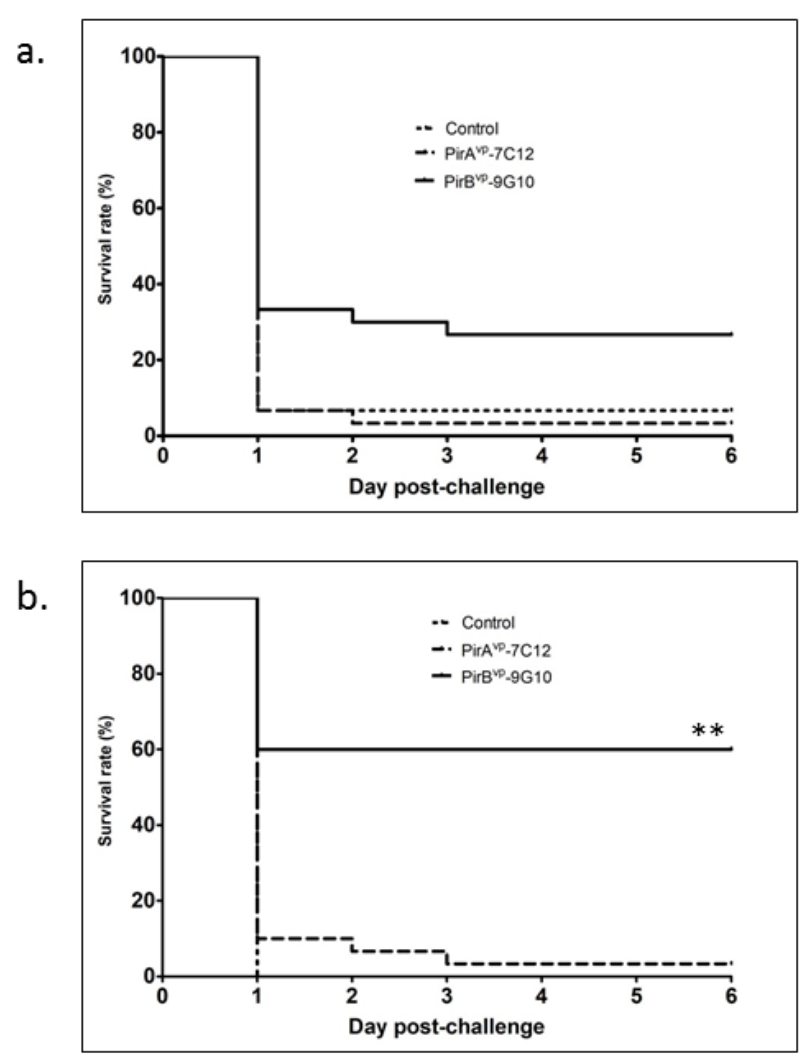
Figure 3. Survival rate of shrimp after bacterial challenge. Shrimp fed with or without VLRB anti- bodies were challenged with Vibrio parahaemolyticus by immersion and mortality was recorded for six days. ( a ) first trial and ( b ) second trial. ** Statistically significant p <